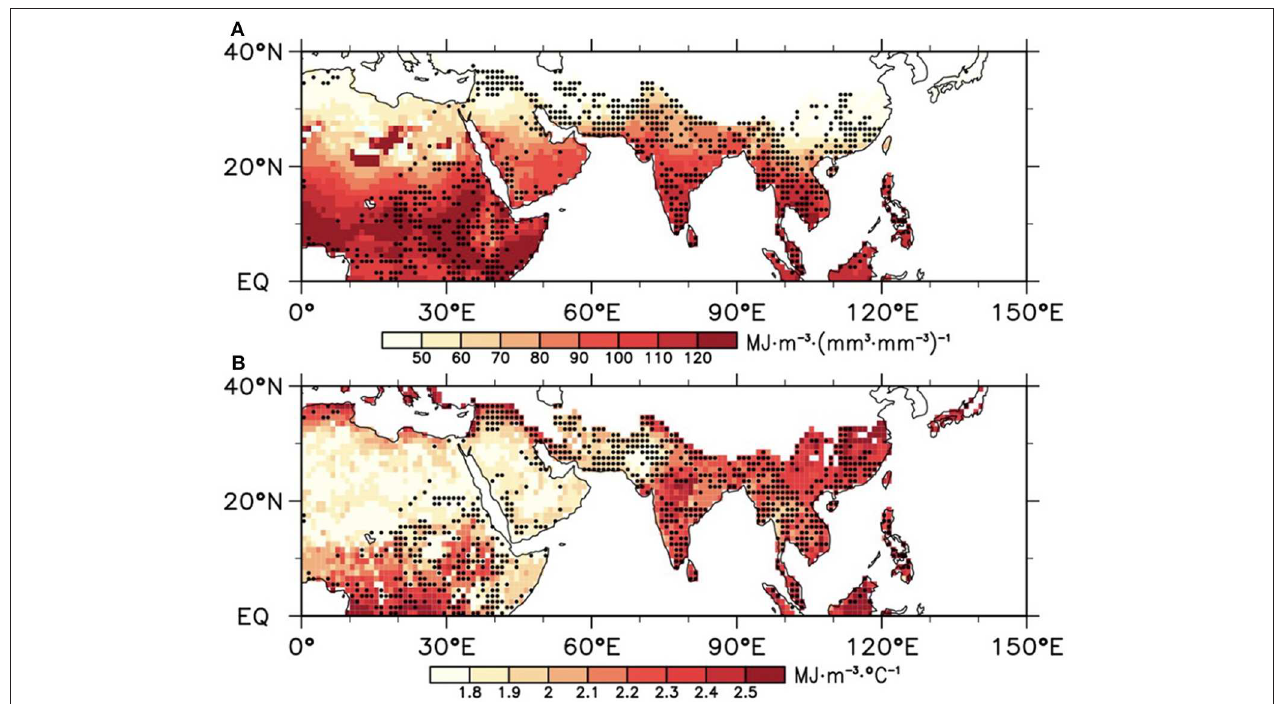
FIGURE 8 | The multiple linear regression (MLR) coefficients of soil enthalpy on (A) soil liquid water ( a l ) and (B) soil temperature ( b ) at mid-low latitudes. The coefficients in the regions with solid black dots are statistically significant ( p < 0.05) after prewhitening.